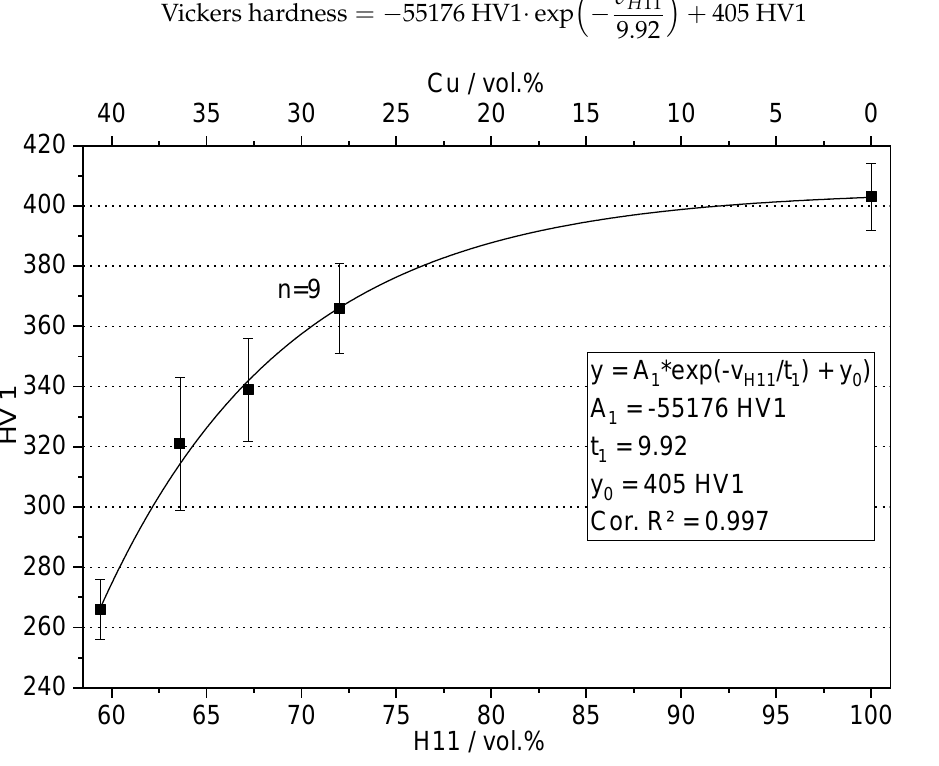
Figure 8. Vickers hardness HV1 of the H11/Cu composite materials and H11 as a function of H11 content in the as-infiltrated/as-sintered